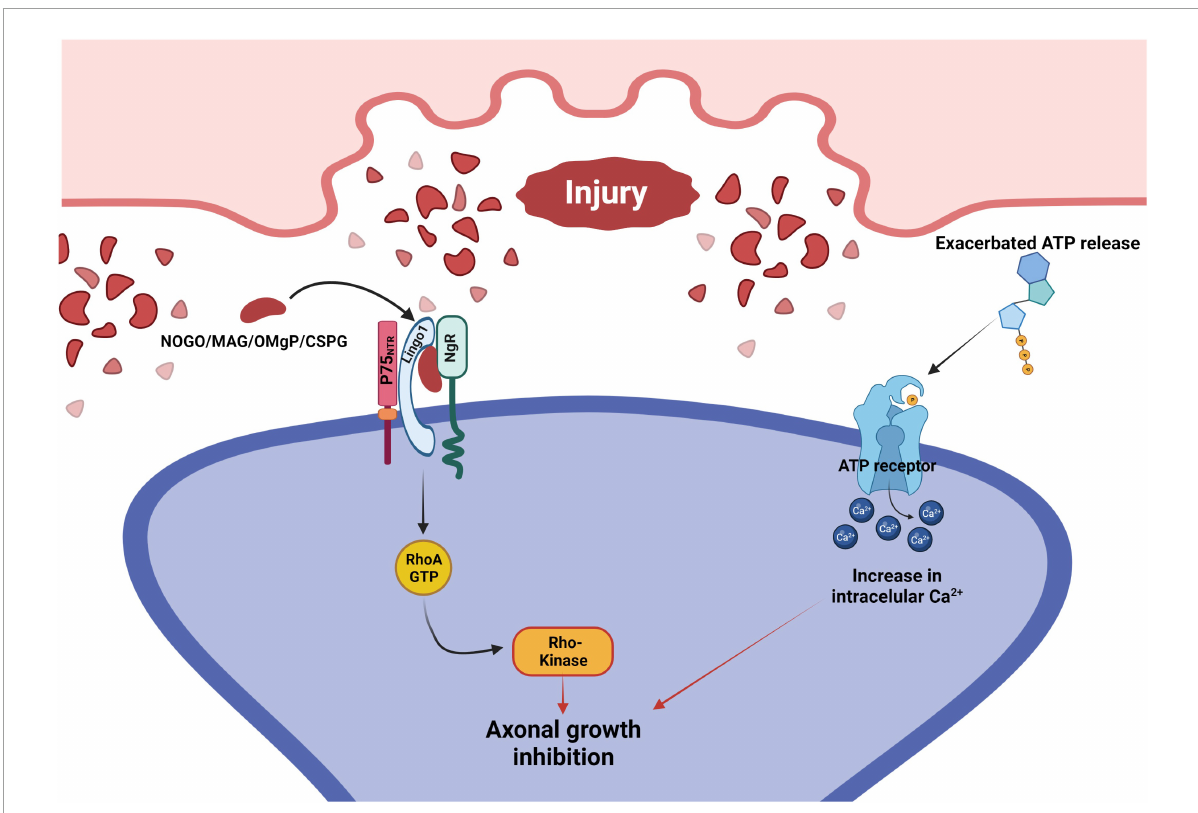
FIGURE3 Signaling pathways that mediate axonal growth inhibition after injury to the CNS. Following an injury, there is an exacerbated release of ATP and an accumulation of growth repressive molecules on the surface of the injured neuron. Growth repressive molecules (Nogo/MAG/OMgP/CSPG) bind to the NgR, which forms a complex with both LINGO1 and P75 NTR . This complex activates the RhoA signaling cascade, leading to the inhibition of axonal growth. At the same time, ATP binds to their neuronal membrane surface receptors, promoting intracellular Ca 2 + increase that inhibits axonal growth. P75 NTR , p75 neurotrophin receptor; LINGO1, leucine rich repeat and immunoglobin-like domain-containing protein 1; NgR, Nogo receptor; MAG, myelin associated glycoprotein; OMgP, oligodendrocyte myelin glycoprotein; CSPG, chondroitin sulfate